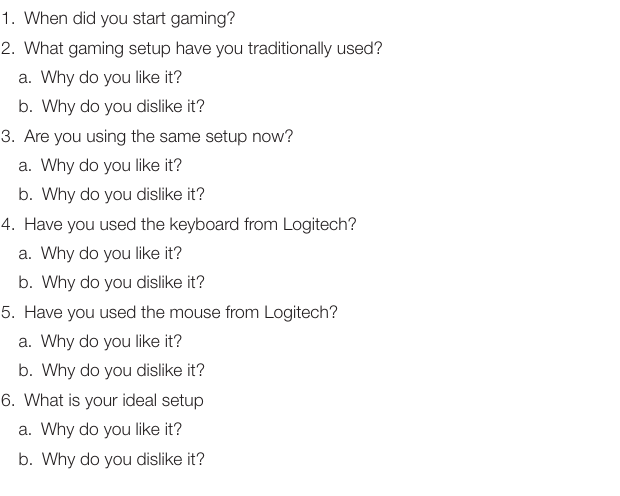
TABLE 1 | Phone interview questionnaire.